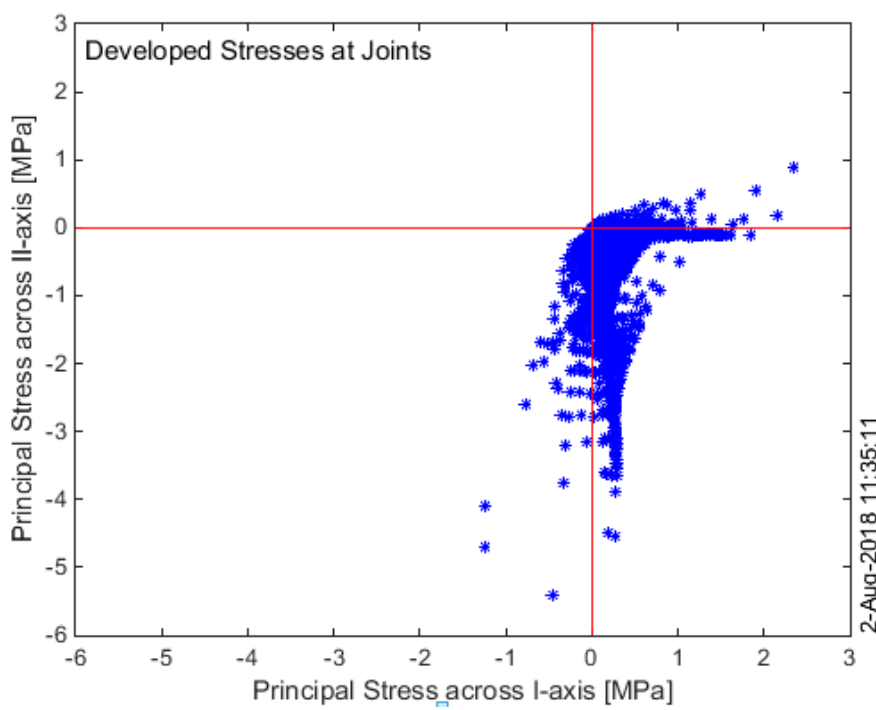
Figure 27. Developed stresses in principal stresses terms (PGA = 0.40 g).